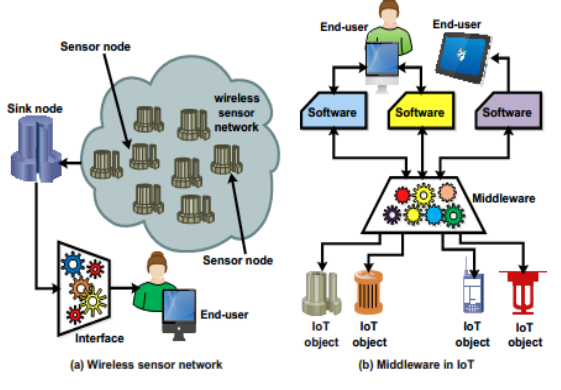
Figure 8. A typical WSN and Role of Middleware in